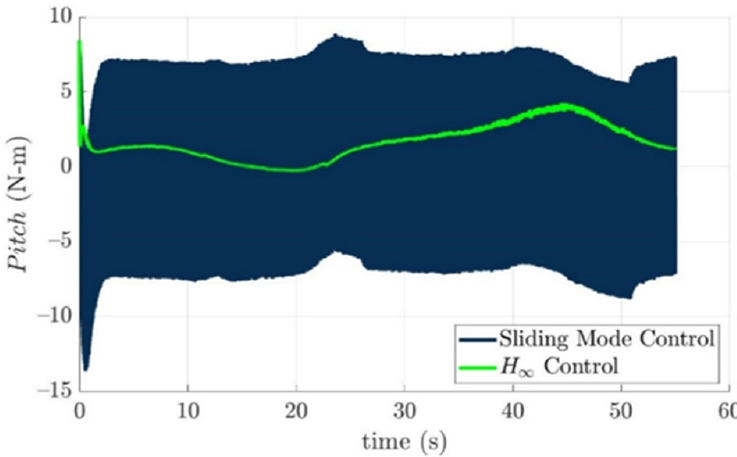
Figure 18. Roll moments of the developed torpedo-like underwater vehicle with respect to the sliding mode control law and the nonlinear H ∞ control law.